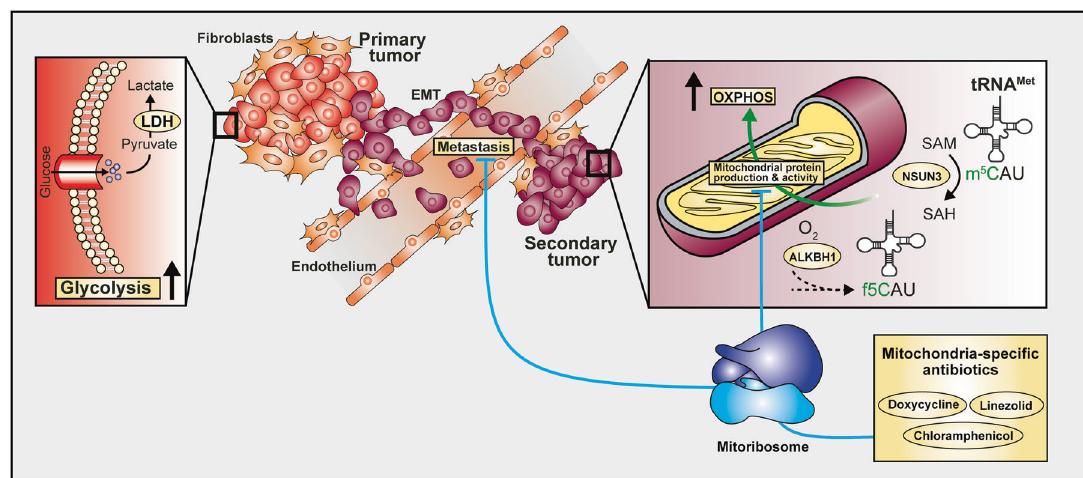
Fig. 1 Mitochondrial tRNA modi fi cations are involved in development of metastases by regulating metabolic plasticity of invasive tumor cells. Due to shortage of oxygen and nutrients in the tumor microenvironment of primary tumors, the tumor cells utilize glycolysis instead of OXPHOS for their energy supply. The metabolic switch from glycolysis to OXPHOS occurs when invasive tumor cells leave the primary tumors and settle in a new area (secondary tumors). Speci fi c mitochondrial tRNA modi fi cations such as m 5 C and f 5 C are introduced by the tRNA- modifying enzymes NSUN3 and ALKBH1, respectively. These modi fi cations are essential for optimal protein synthesis of enzymes involved in mitochondrial respiration. In mice bearing neck or head tumors, depletion or pharmacological inhibition of NSUN3 leads to reduction of m 5 C in mitochondrial tRNA, resulting in decreased metastases in both lymph nodes and lungs. Similar effects on metastases can be achieved by using mitochondria-speci fi c